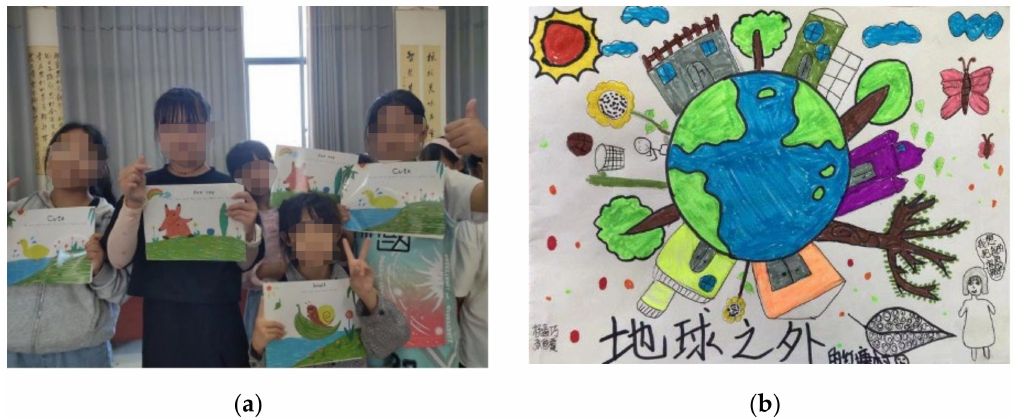
Figure 6. The jointly organized painting activity by planners, local village committee members, and third parties to activate children’s perceptions of their home village. ( a ) Some primary school students who participated with their paintings; ( b ) One of the paintings made by a primary school student. Source: the authors, taken in August 2022. The Chinese words in the picture serve as title, which means “Hongtang Village outside the